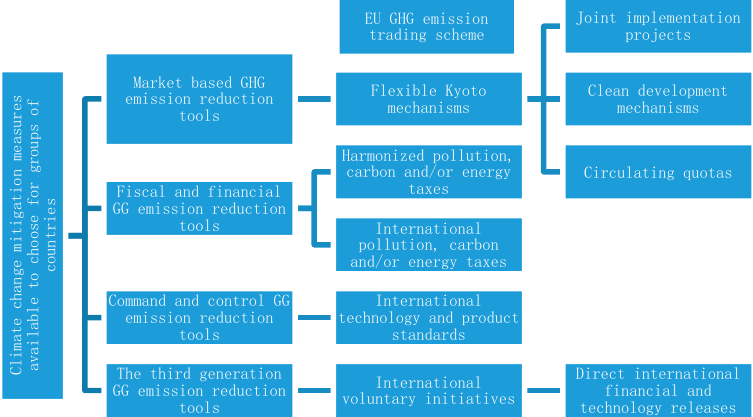
Figure 2. Climate change mitigation measures that can be selected by a group of parties individually or in combination. Source: created by authors. EU: European Union; GHG: greenhouse